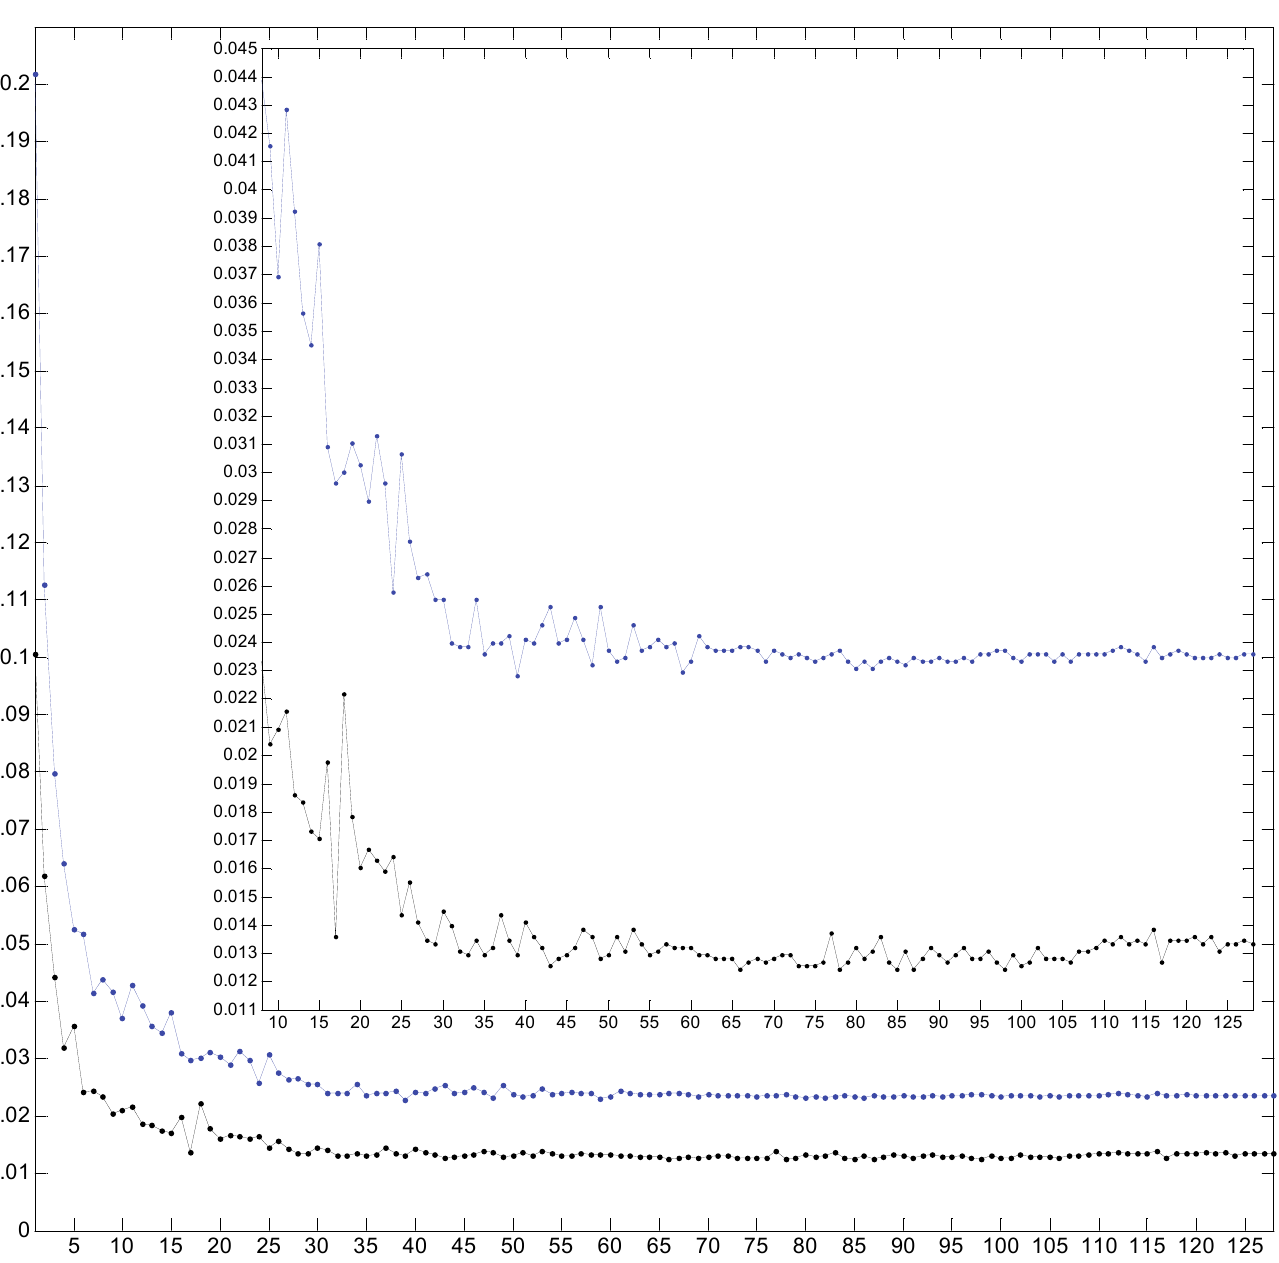
Fig. 7. The performance   32 V by (19) at 1,128 p  as the lower polyline against the upper polyline   24